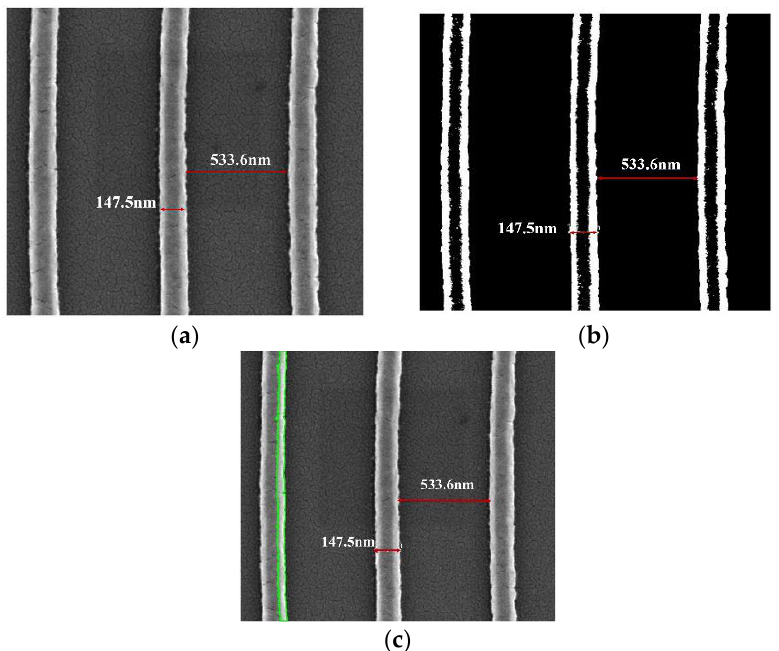
Figure 3. The boundary tracking before reactive ion etching. ( a ) original image; ( b ) binary image; and ( c ) application results.